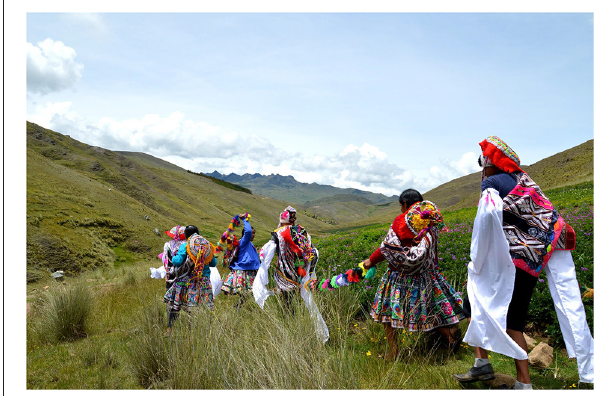
FIGURE 2 | Parque de la Papa community members celebrate the annual festival of “Papa Tinkay,” a ritual offering to the flowering potato plants to bring a fruitful harvest (Agroecology Fund, 2020). Image by Asociación